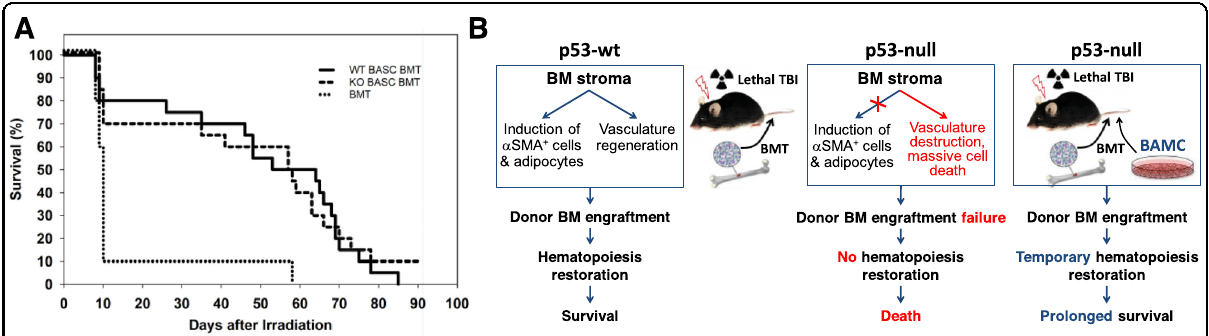
Fig. 7 Supplementation of BM with BAMC improves survival of p53-null mice after IR and BMT. A Three groups of p53-null mice ( n = 20/ group) received total BM cells (5 × 10 6 ) from p53-WT mice by tail vein infusion 48h after 12 Gy TBI. Two groups also received 3 × 10 5 BAMC from p53- WT or p53-null mice, respectively, at the same time via tail vein. Survival of recipient mice was followed for 90 days after IR. The difference in survival fraction (%) between mice given BMT only and mice given BMT plus BAMC from p53-WT or p53-null mice was statistically signi fi cant ( p < 0.01 by two-tailed Fisher ’ s exact test) up to day 60 post IR, at which point all BMT only mice were dead. B Scheme: p53 determines radiosensitivity of hematopoietic and radioresistance of stromal component of BM. p53-null mice cannot be rescued by BMT from any lethal dose of total body radiation, whereas this procedure enables survival of p53 wild-type mice. Hematopoietic recovery after IR and BMT in p53-WT mice correlated with the appearance IR-induced α SMA + stromal cell population and increased adiposity which were absent in p53-null mice. The level of IR-induced injury of BM stromal compartment in p53-null mice is higher compared with p53-WT mice and cannot support the proliferation of hematopoietic cells after BM engraftment. Supplementation of the donor BM with bone marrow adherent stromal cells from non-irradiated mice enables engraftment of pluripotent hematopoietic precursors and temporary restoration of hematopoiesis in irradiated p53-null